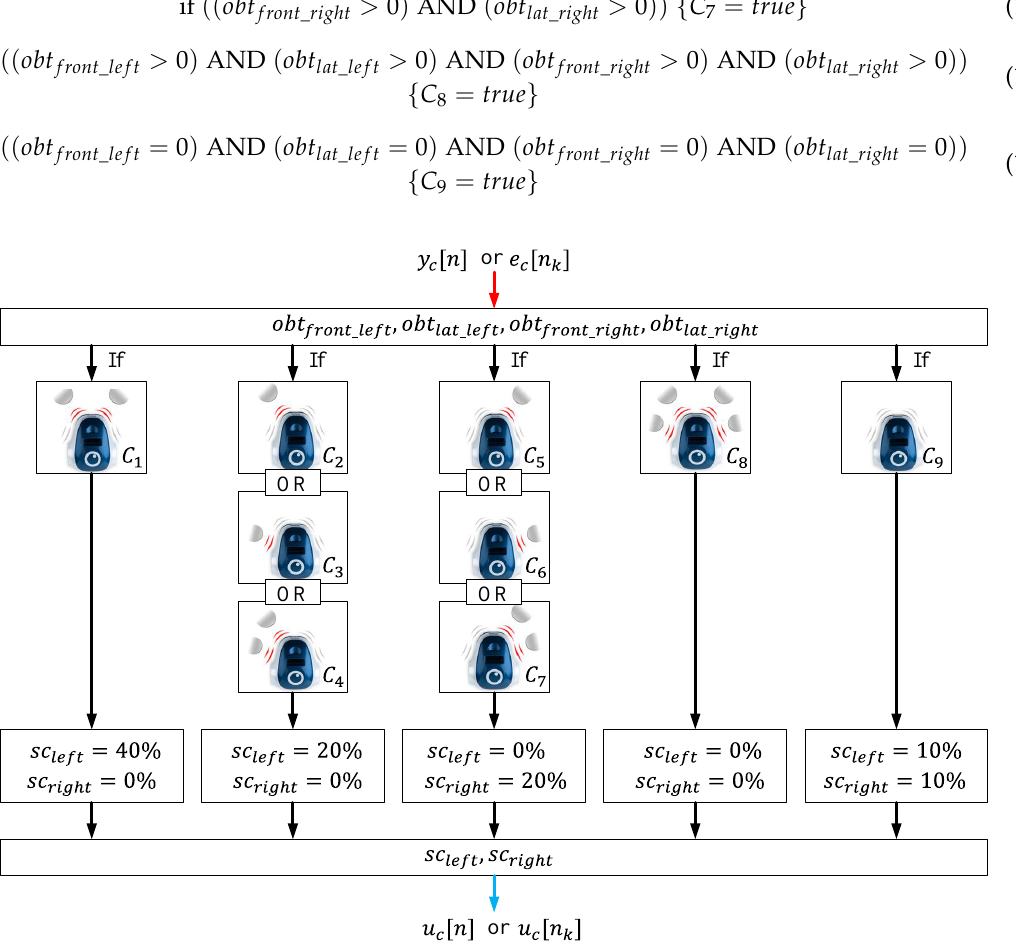
Figure 7. Block diagram of the obstacle avoidance